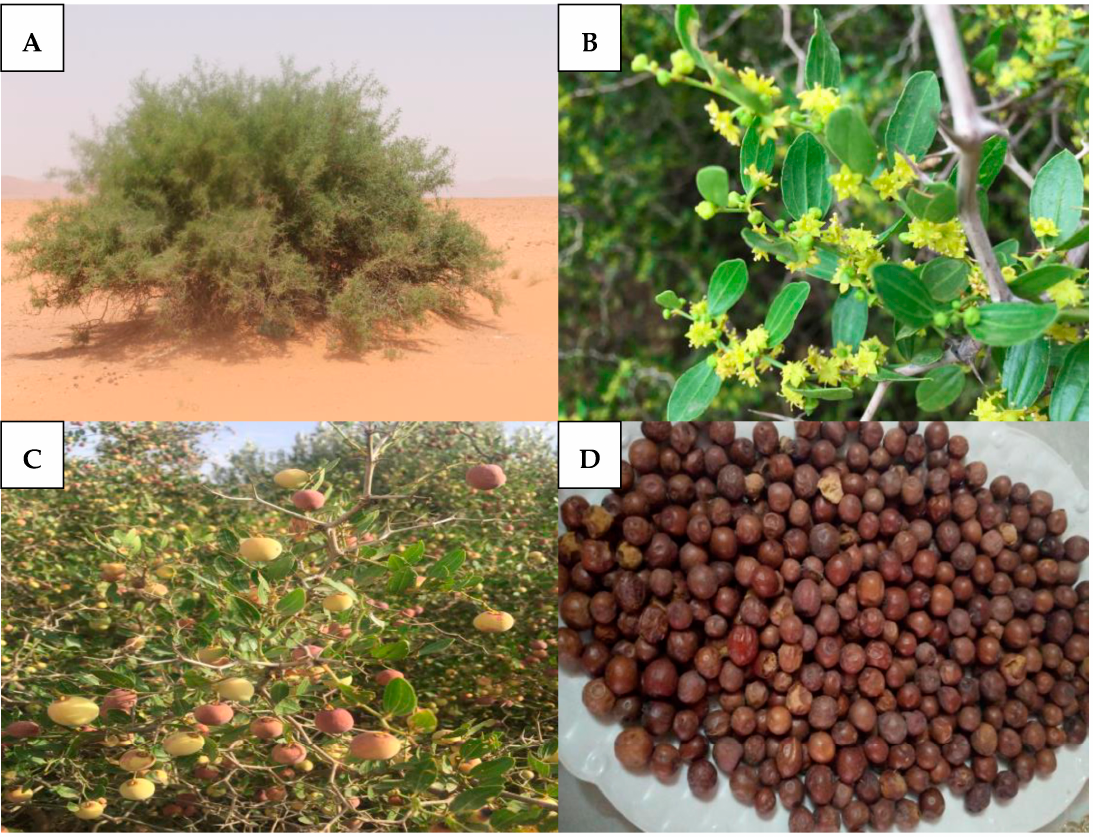
Figure 1. ( A ) Global view of Z. lotus . ( B ) Leaves of Z. lotus in the flowering stage. ( C ) Z. lotus fruits in ripening phase. ( D ) Mature Z. lotus fruits.